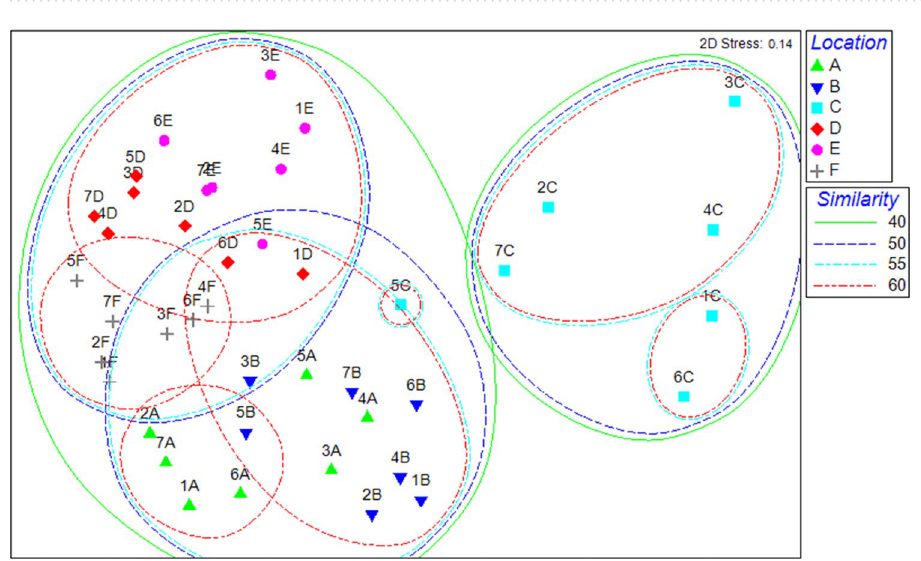
Figure 3. Non-metric Multidimensional Scaling (NMDS) plot depicting the spatial variation of the benthic macroinvertebrate assemblages between the six study sites (sites F–E–D are located above the weir and sites C–B–A are located below the weir, see Fig. 5) from May (1) to November (7),